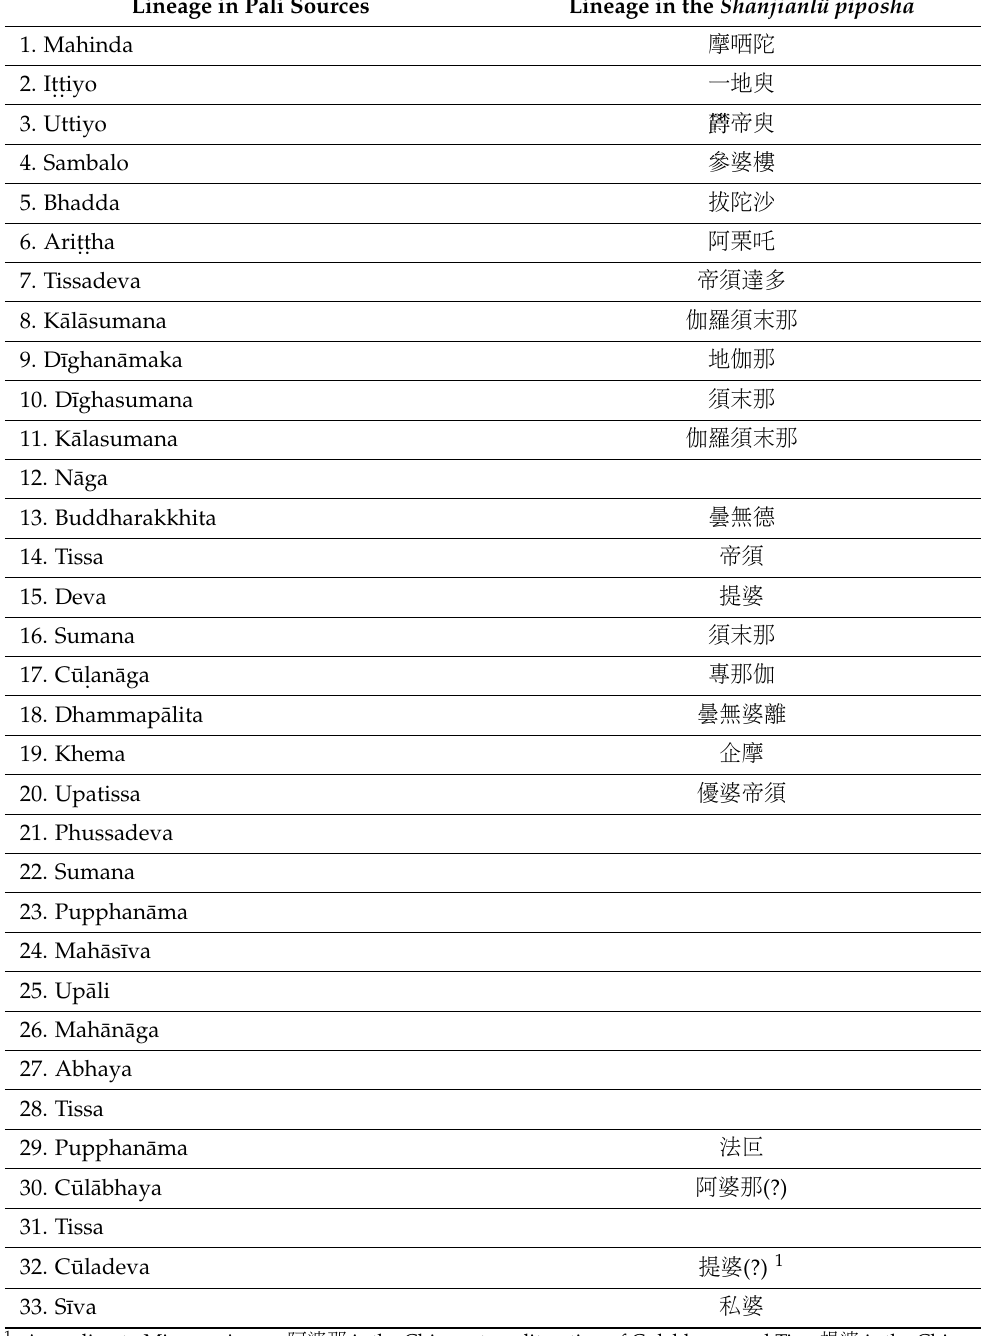
Table 1. A comparison of the lineages in the Shanjianlü piposha and P¯ali